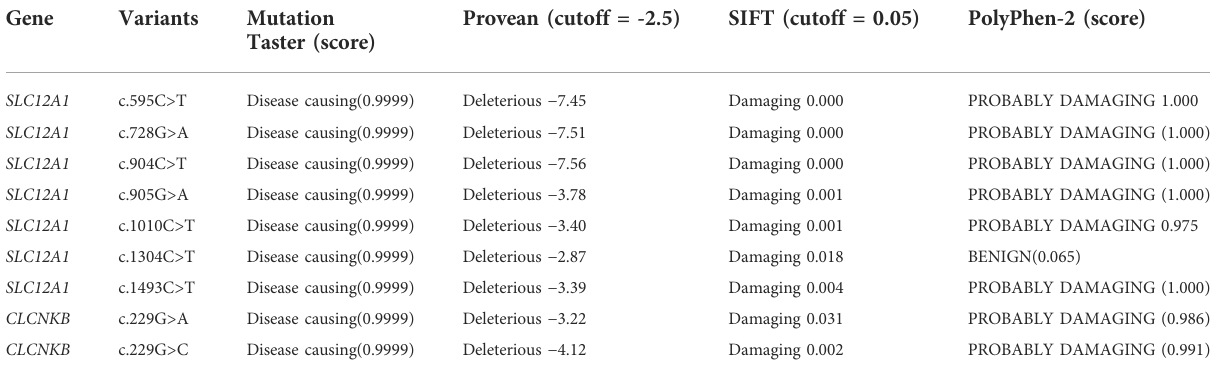
TABLE 2 Prediction of the potential pathogenicity of the missense